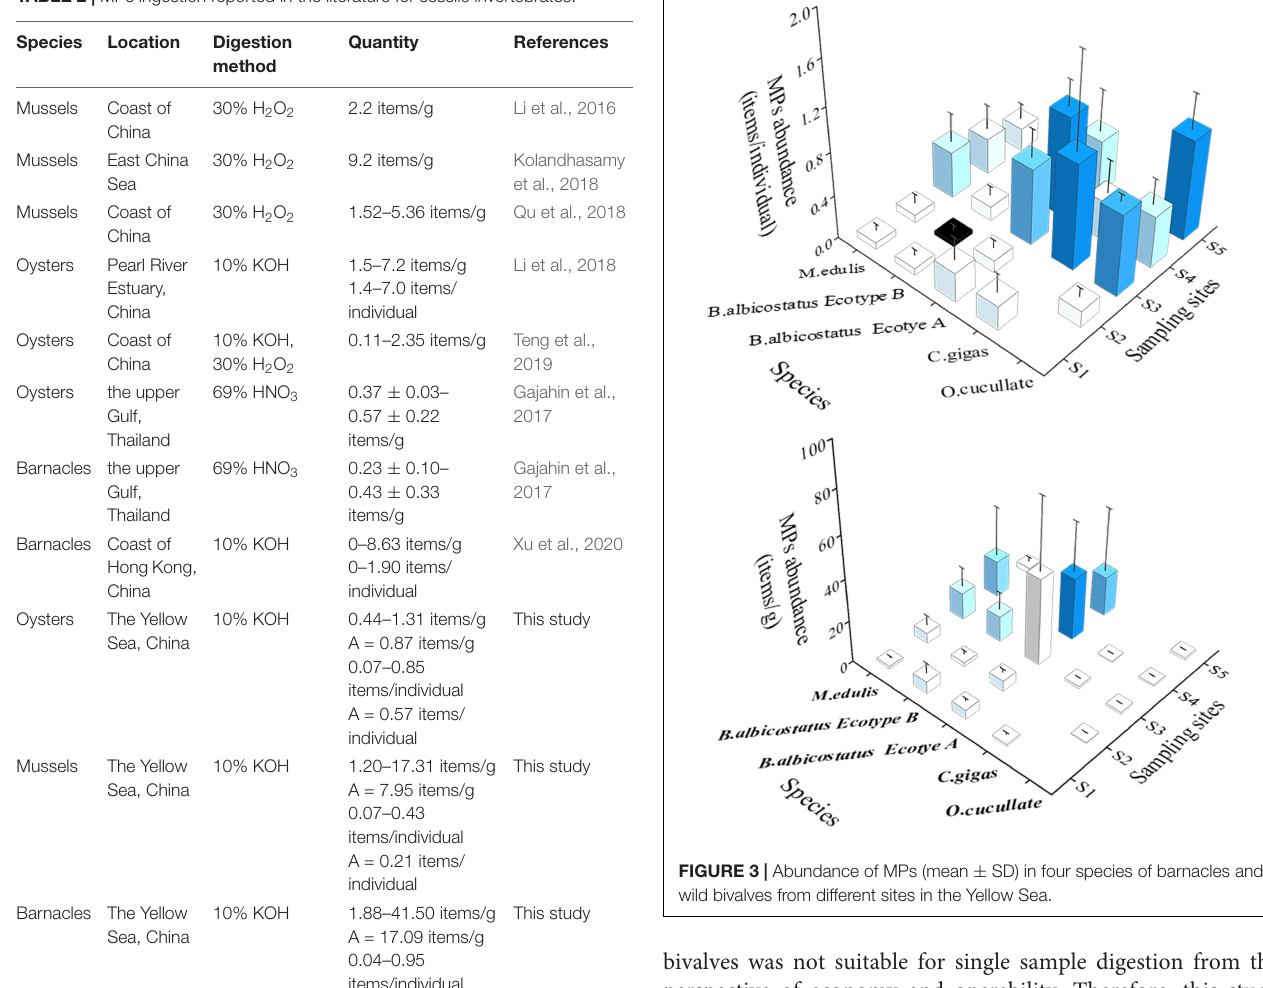
TABLE 2 | MPs ingestion reported in the literature for sessile invertebrates.